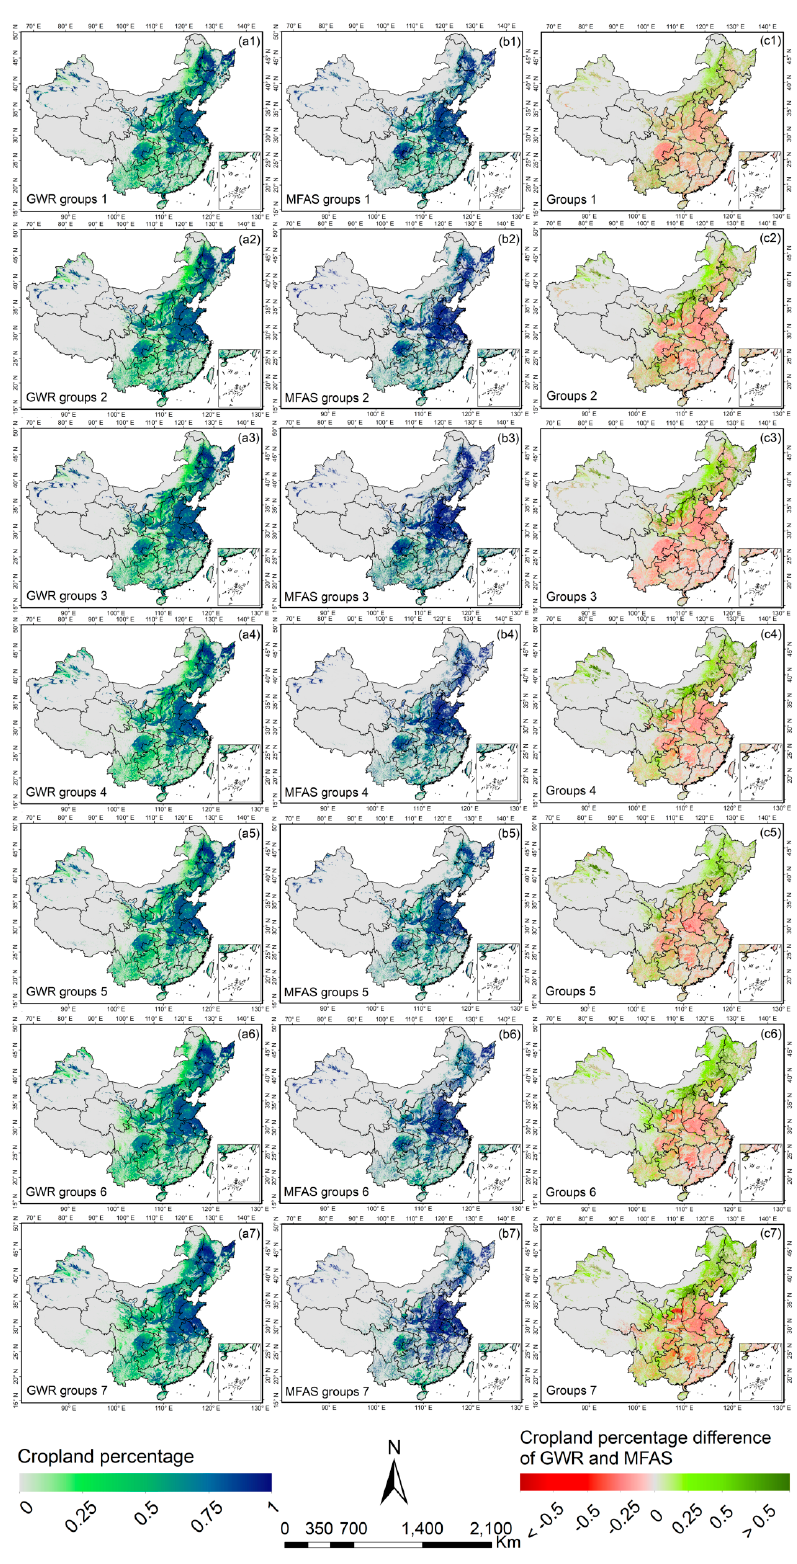
images ( right panel ). Panels from top to bottom represent synergy results with various average accuracy of input satellite-based map combinations as shown in Table